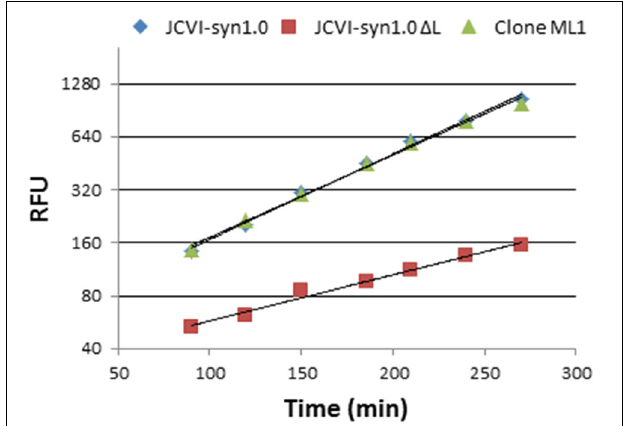
FIGURE 5 | Restoration of the replication rate of JCVI-syn1.0 (cid:2) L by inserting complementation fragment 1 (containing nusG ) via the marker-less approach. The line for JCVI-syn1.0 (blue) and the line for rescued clone ML1 (green) overlap. Doubling times calculated from PicoGreen fluorescence (RFU) are 62min for JCVI-syn1.0 ( y = 54 . 732e 0 . 0112 x , R 2 = 0 . 9951), 64min for complemented clone ML1 ( y = 58 . 374e 0 . 0108 x , R 2 = 0 . 9951), and 116min for JCVI-syn1.0 (cid:2) L ( y = 31 . 425e 0 . 006 x , R 2 = 0 . 983).